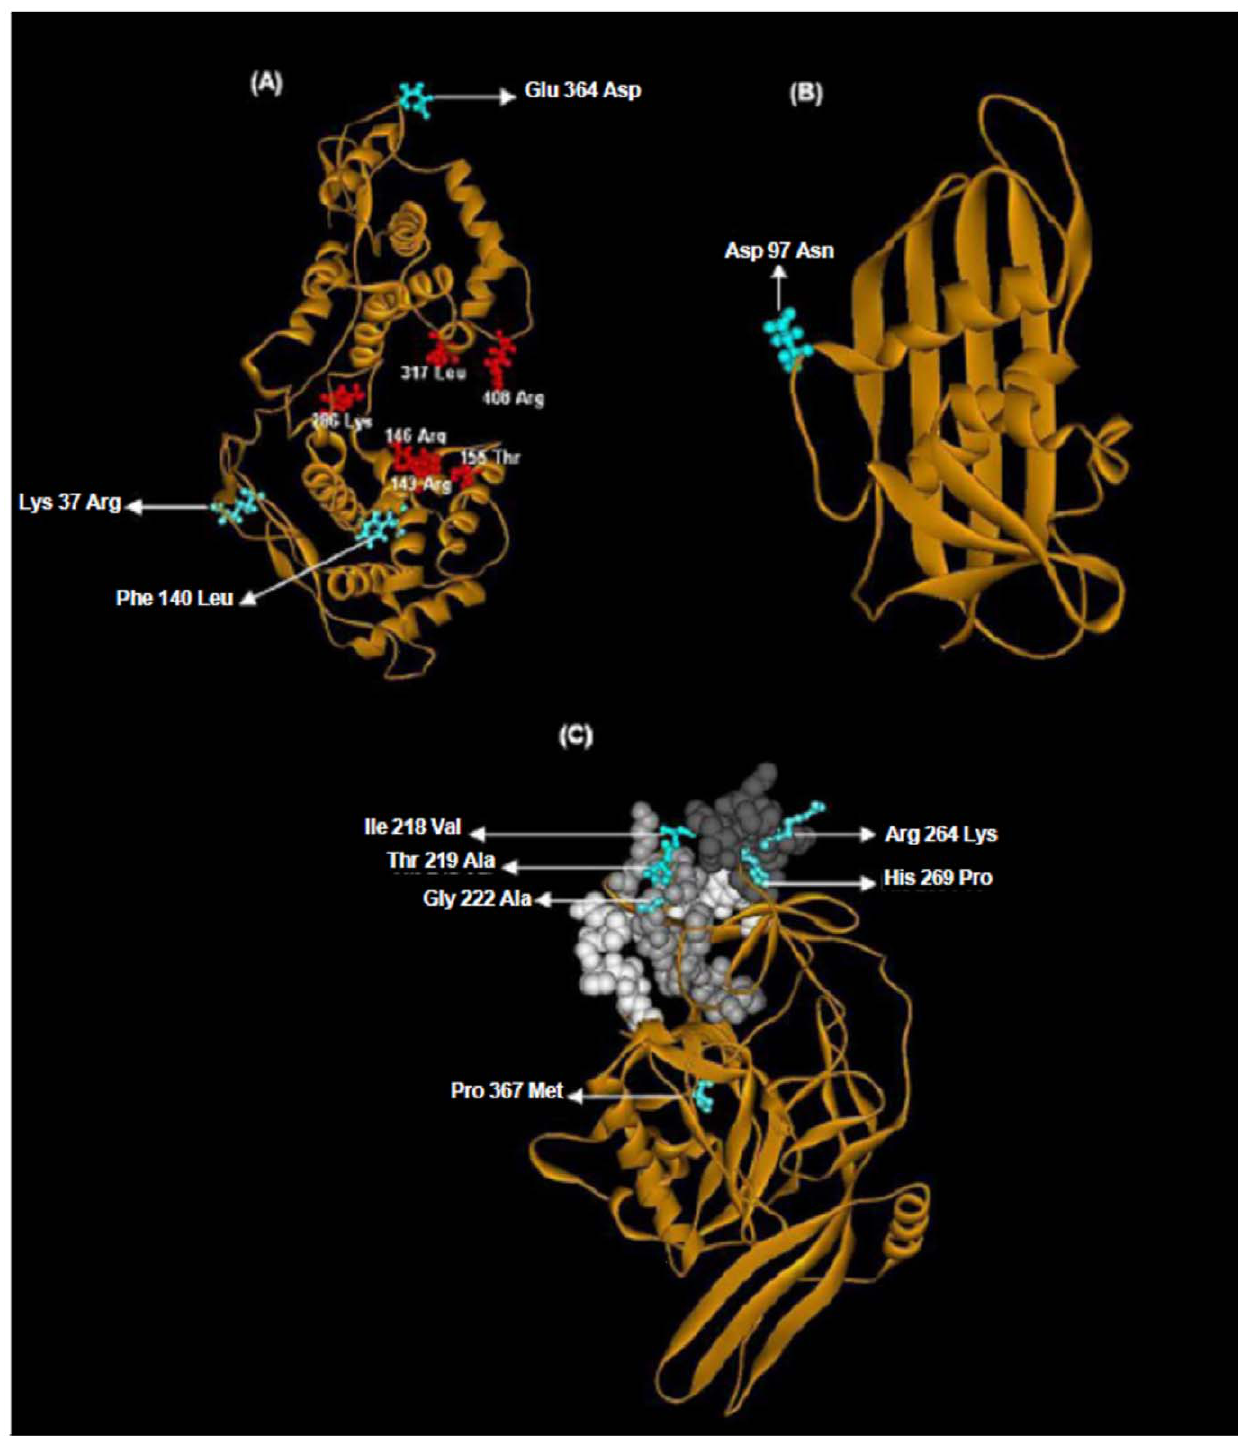
Figure 3. Homology models of CHPV proteins and mapping of significant functional residues. All observed CHPV mutations (residue numbering as per the location in the sequence) in cyan. (A) Nucleoprotein: RNA binding residues shown in orange, residues part of RNA binding groove in blue and loop Ser340-Val375 in yellow. (B) Matrix (C) Glycoprotein: BEFV antigenic site G3 shown in shades of grey.